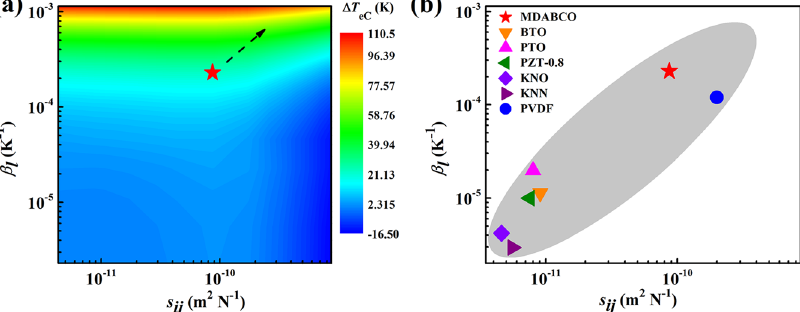
Fig. 6 Design space for high eC materials with respect to the linear thermal expansion and elastic compliance. a Two-dimensional plot of the evaluated eC temperature change Δ T eC for [MDABCO](NH 4 )I 3 based metal-free ferroelectrics as a function of β l and s ij . The red star represents the [MDABCO](NH 4 )I 3 and the dashed arrow points out the direction for the design of organic ferroelectrics with high eC properties. b The thermal expansion coef fi cient β l and elastic compliance s ij for different ferroelectrics. The compressive stress and the mis fi t strain are fi xed at 1.28 GPa and 0.01, respectively.